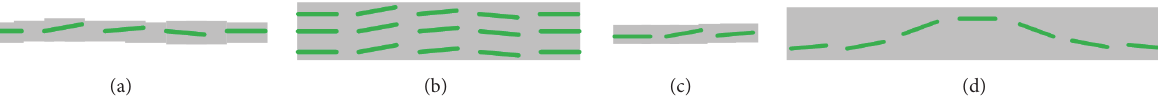
Figure 7: Illustration of different support areas including (a) straight line, (b) monotonous region, (c) isolated noise, and (d) low-curvature curve. (b) and (c) could be discarded by criterion 1; (d) could be discarded by criterion 2.